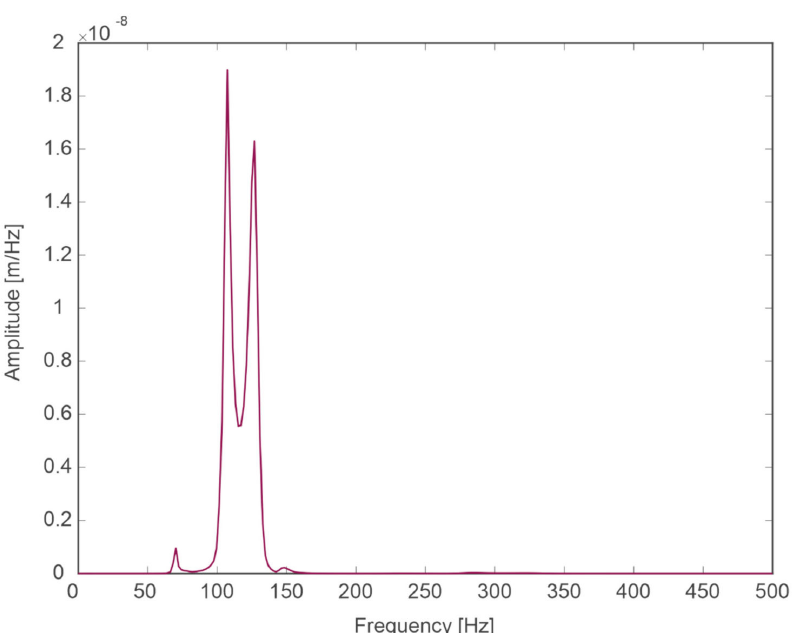
Figure 21. Spectrum generated from vertical displacement in the direction y of the capsule at a speed of 2000 km /